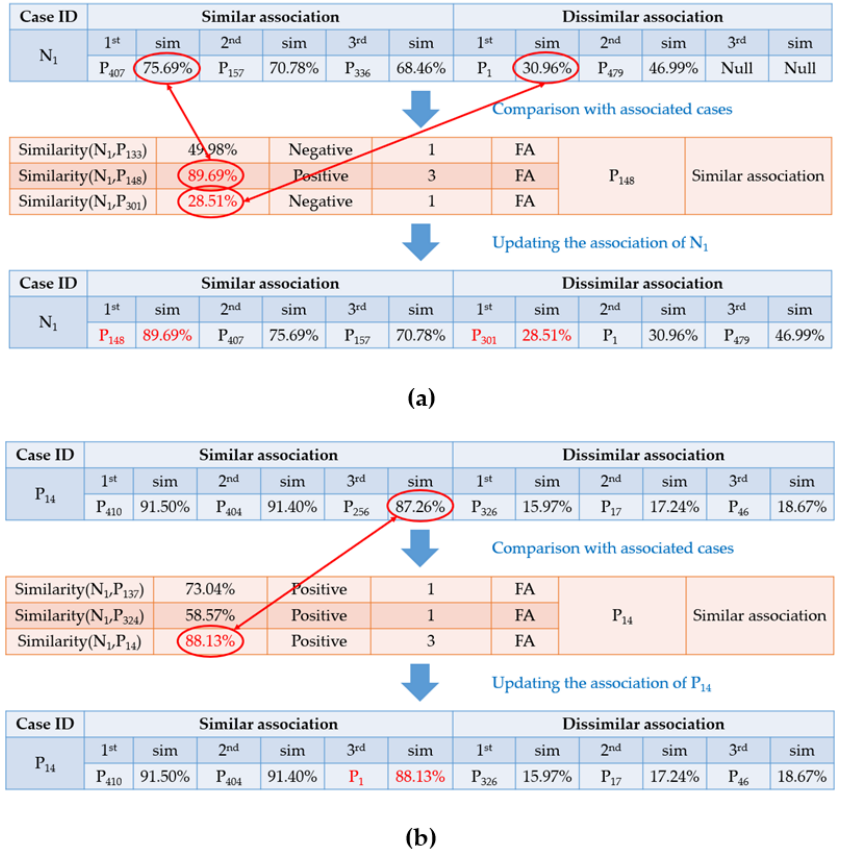
Figure 5. Examples of updating the association table: ( a ) scenario 1 and ( b ) scenario 2.